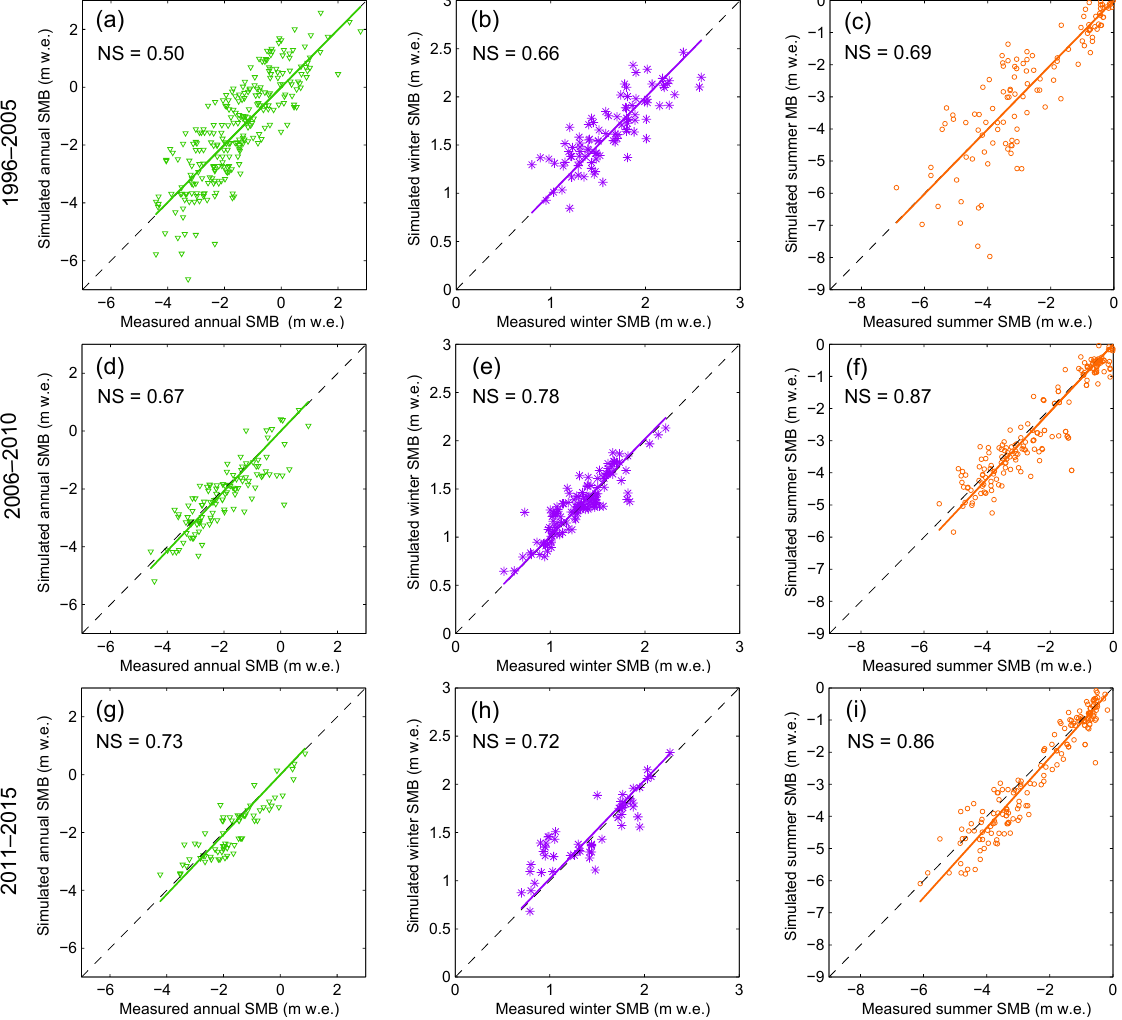
Figure 3. Comparisons between simulated and measured SMBs (mw . e . ) at each measurement point over the 1996–2005 (in situ meteoro- logical measurements not available; a–c ), 2006–2010 (in situ meteorological measurements available on the moraine and on the glacier; d–f ) and 2011–2015 (in situ meteorological measurements available on the moraine only; g–i ) periods. The annual (a, d, g) , winter (b, e, h) and summer (c, f, i) SMBs are shown in green, purple and orange, respectively. The Nash–Sutcliffe coefficient (NS) is indicated on each